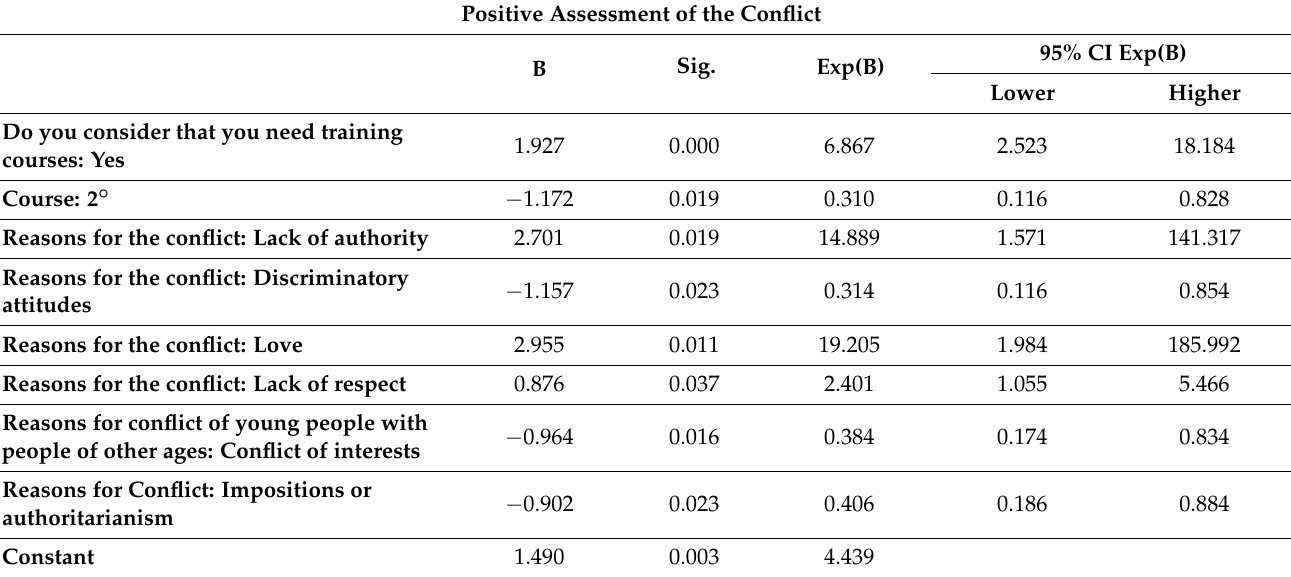
Table 4. Summary of the binary logistic regression